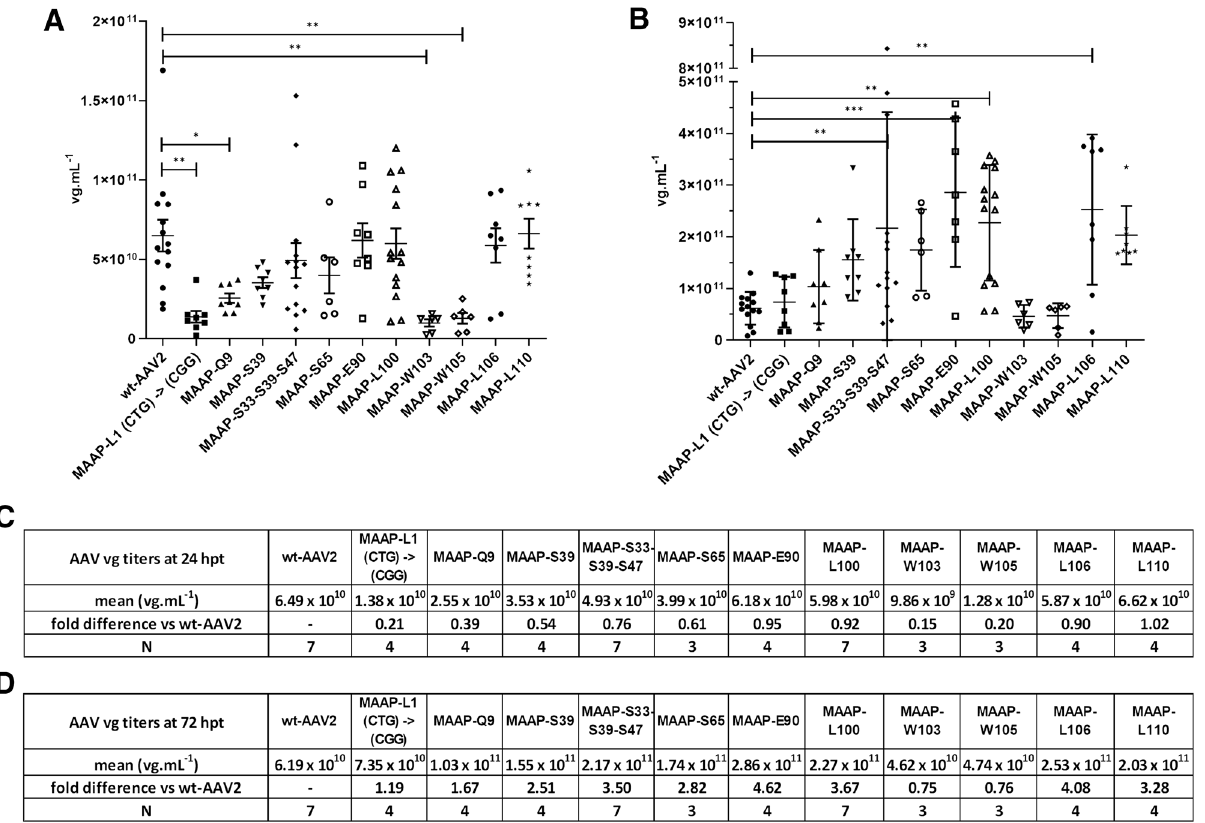
Figure 9. Effect of MAAP inactivation on AAV2 vg titers. wt-AAV2 or AAV2 MAAP variants and Ad helper plasmids were co-transfected in 293 T cells. At 24 hpt ( A ) and 72 hpt ( B ) AAV vg titers were quantified, with results expressed as vg mL −1 with mean and SD. Statistical significance between wt-AAV2 and AAV2 MAAP variants was evaluated using ANOVA followed by Dunnett’s multiple comparison test. The table represents the average vg mL −1 titer measured for each virus, along with the fold difference compared to wt-AAV2 at 24 hpt ( C ) and 72 hpt ( D ). Experiments were performed independently between 3 and 7 times (indicated as N), each time with two replicate